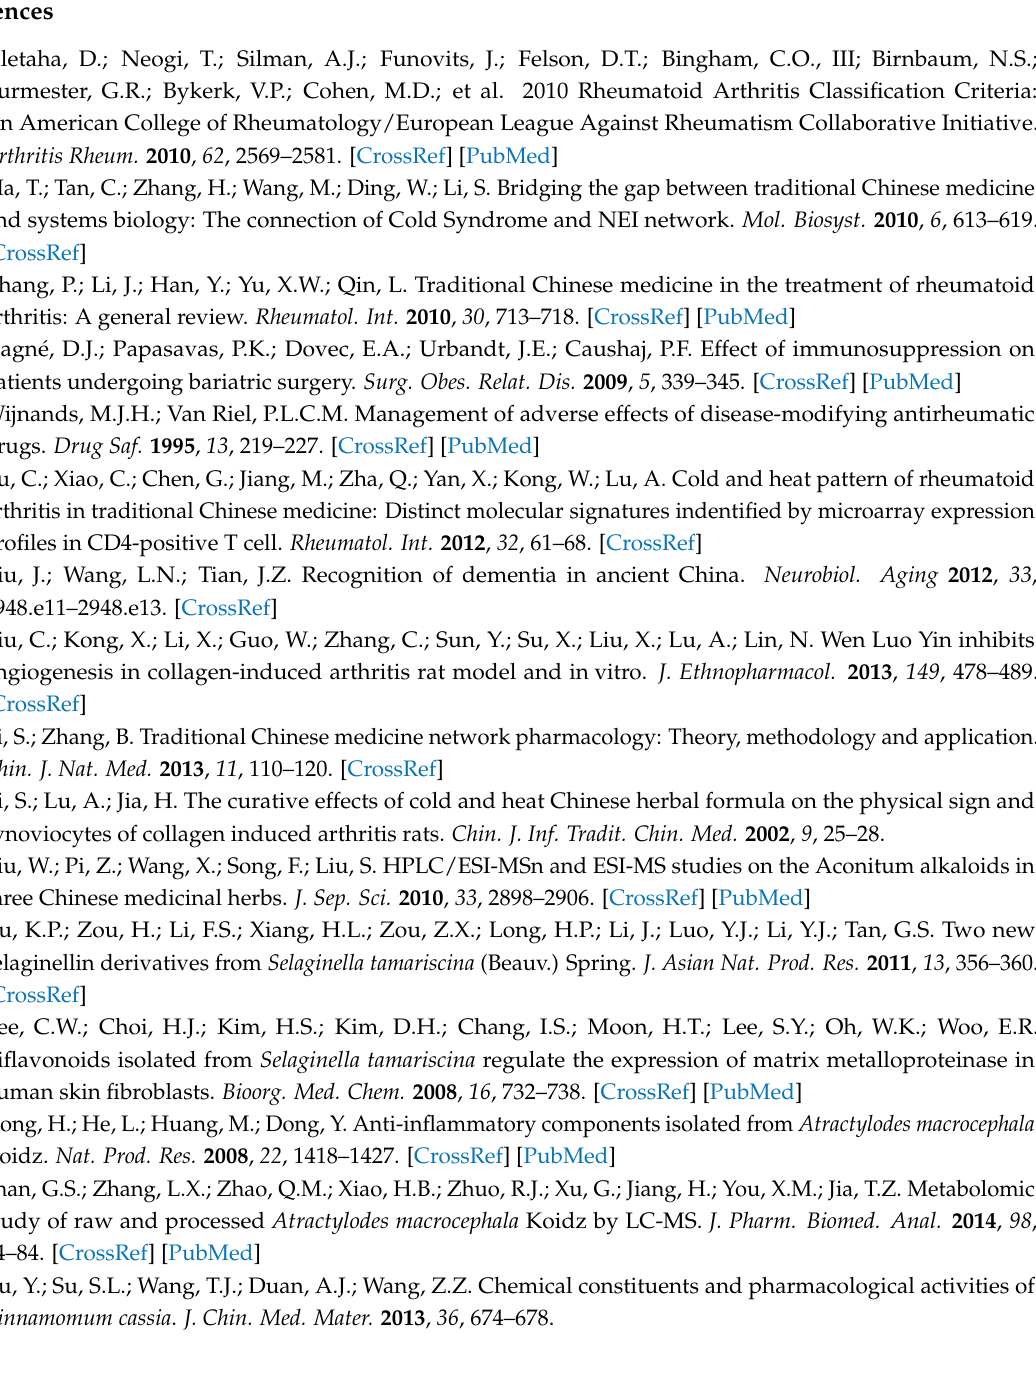
article. Figure S1: The proposed fragmentation pathways of the identified compounds from WLY. Table S1: Characterization of the constituents of WLY by